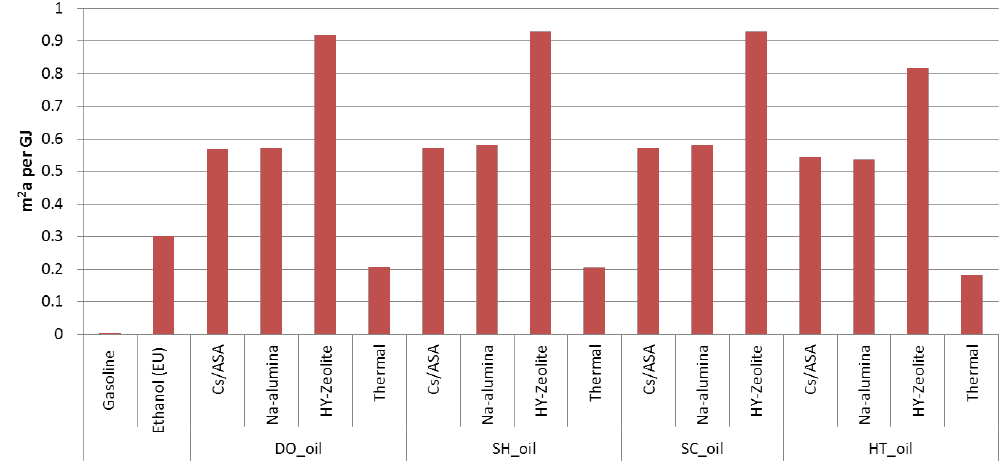
Figure 7. Comparison of the expected land use for pyrolysis biofuel from four cases and four scenarios with ethanol and gasoline. The unit of land use, m 2 a, translates to 1 m 2 of land occupied for 1 year.